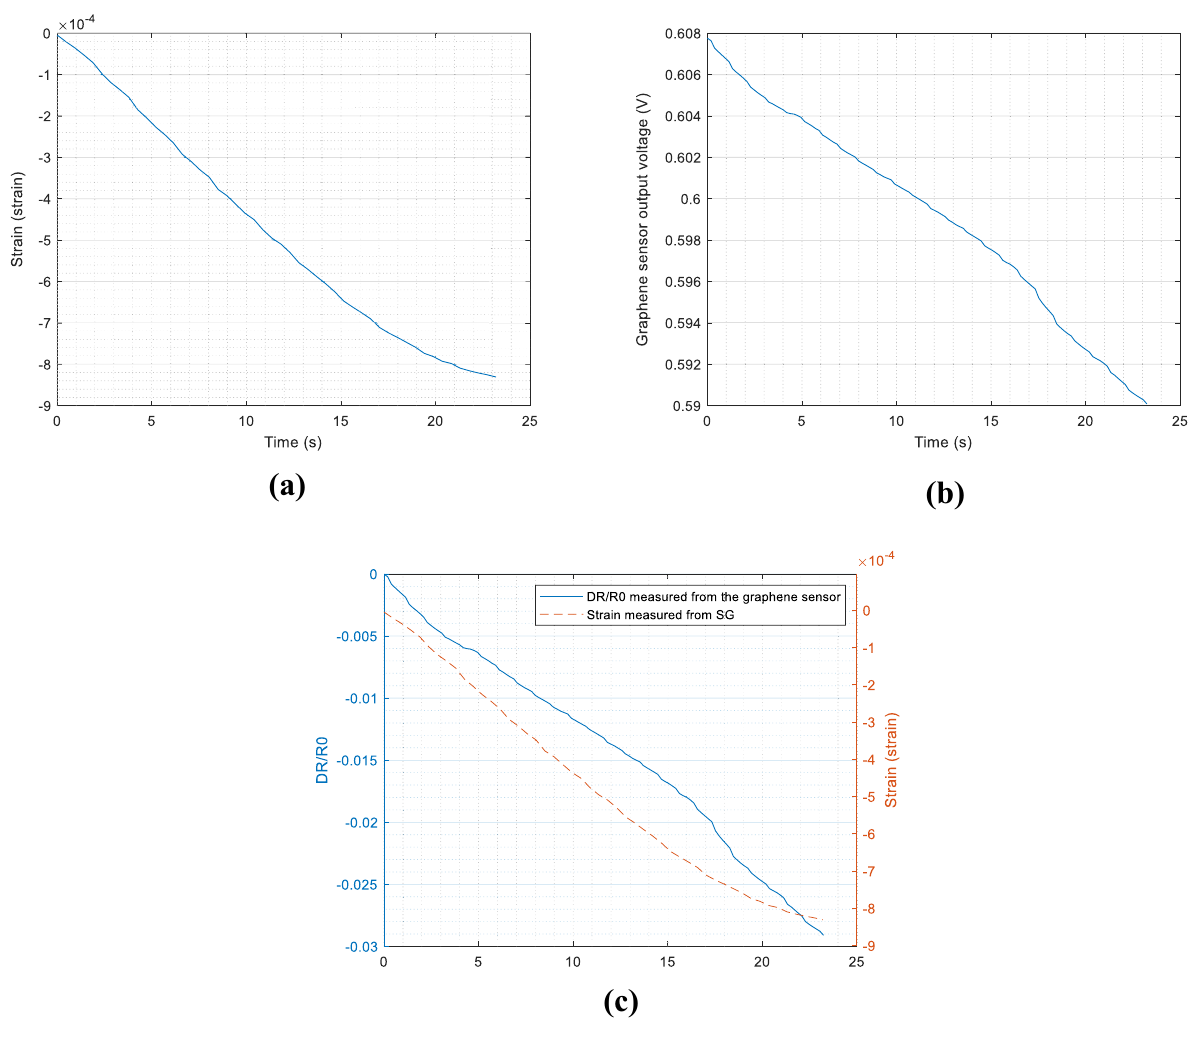
the graphene-based strain sensor to strain measurement obtained from strain gauge under normal compression